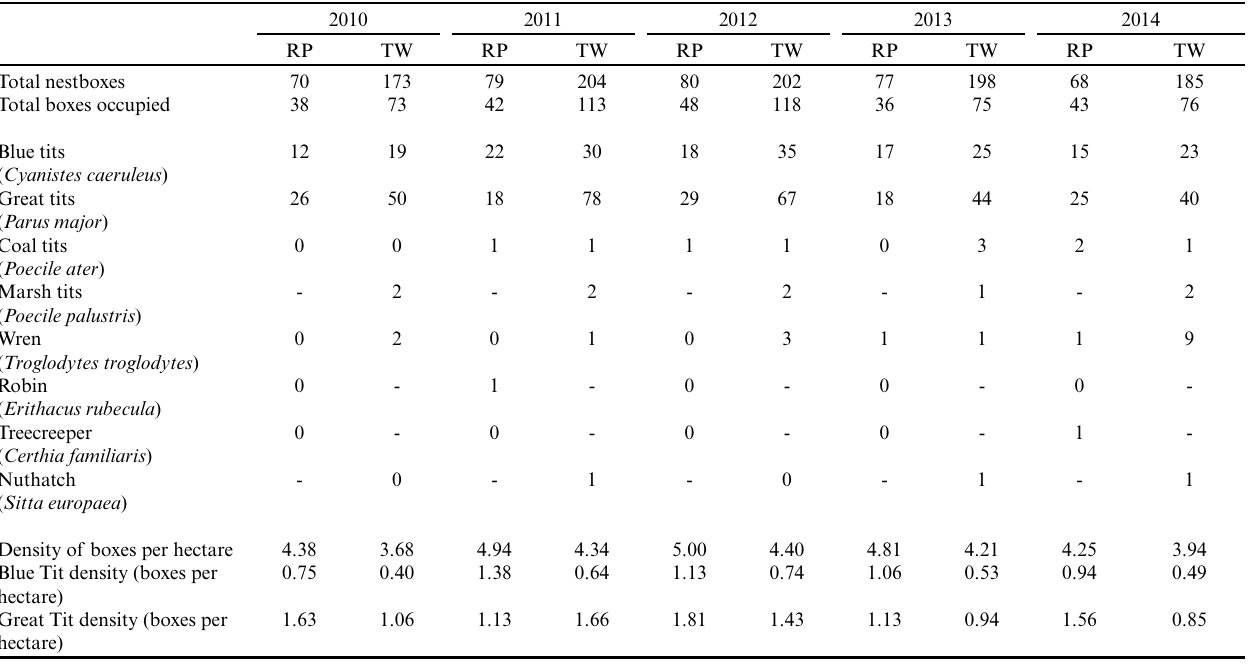
Table 1 . Summary of the number of nest boxes at each site, Riseholme Park (RP) or Treswell Wood (TP), and the number of boxes occupied by the species indicated for each year. Zero indicates that no cases of that species were observed that year but the species did nest during other years and a dash indicates not observed to nest in nest boxes at